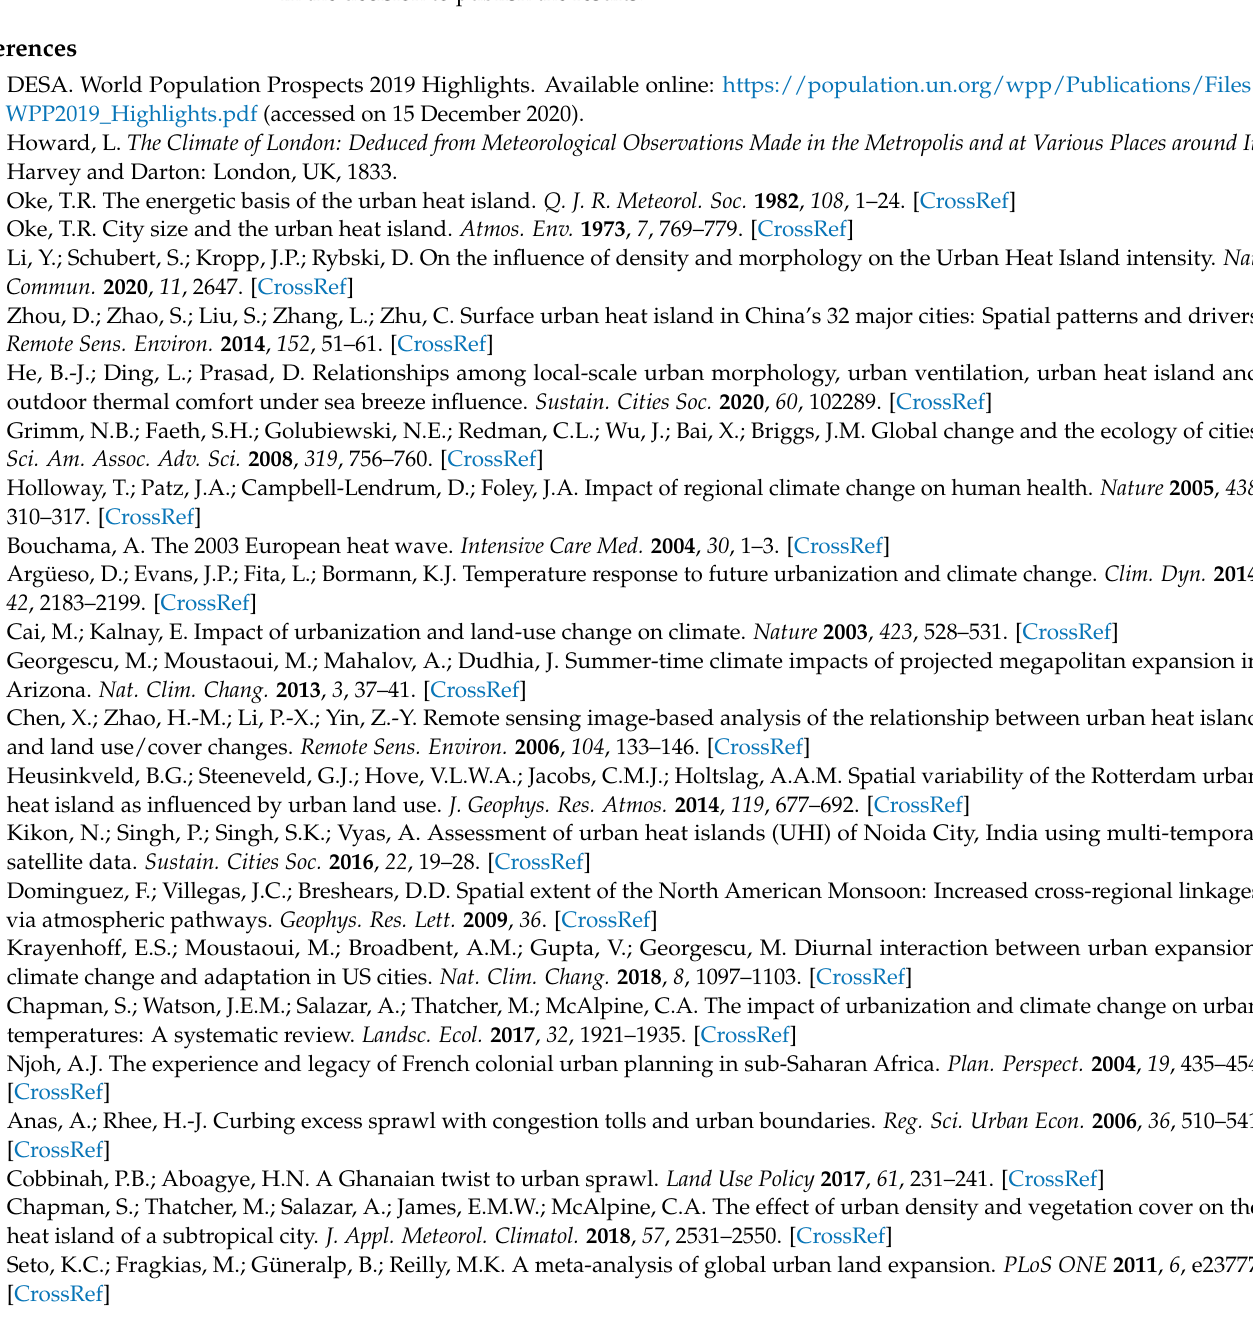
Figure 3 are from https://www.naturalearthdata.com/ (accessed on 30 May